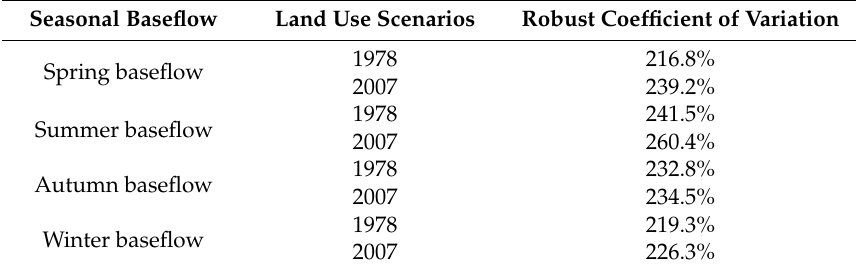
Table 3. Robust coefficient of variation (CV) for the average monthly baseflow of each sub-watershed in this study.